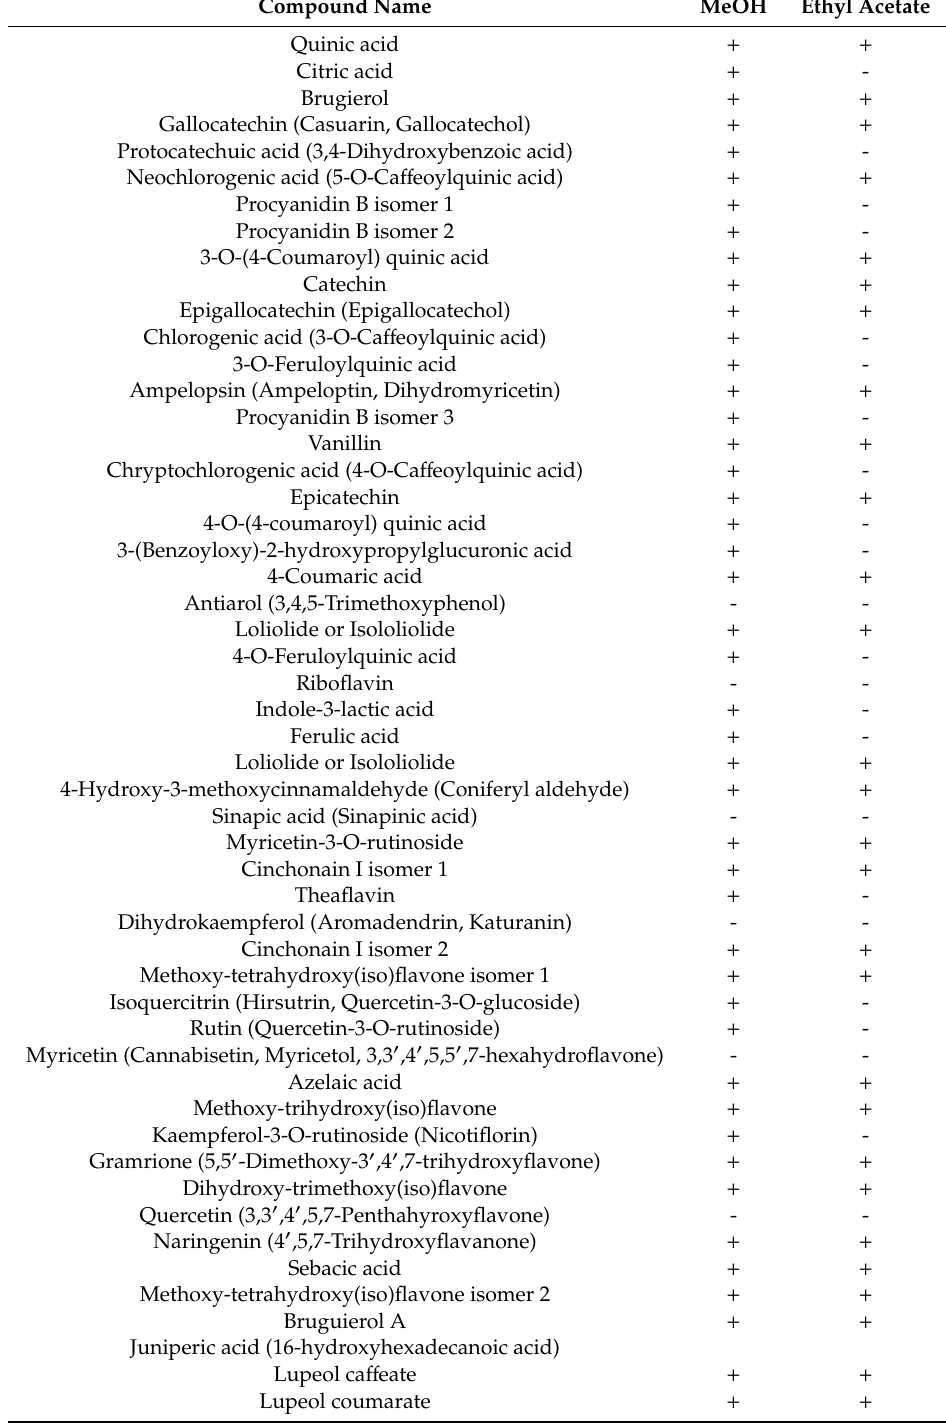
Table 1. Chemical composition of fruit